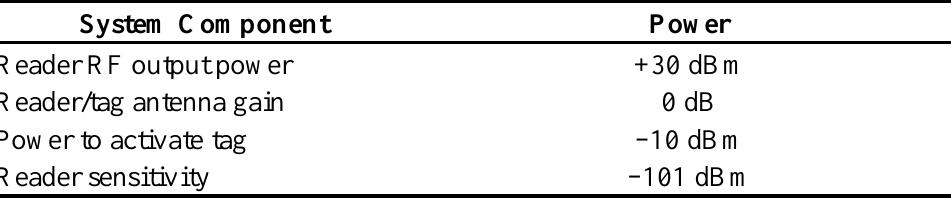
Table 5. Details of the simulated system components